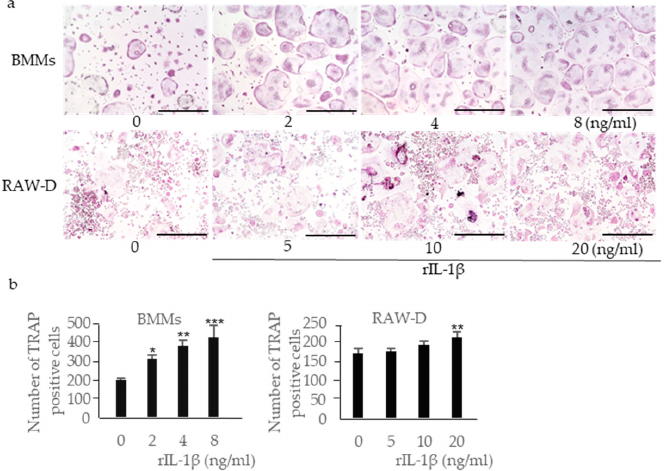
Figure 5. Effects of recombinant (r)IL-1 β on osteoclastogenesis. BMMs were incubated with 30 ng/mL M-CSF and 20 ng/mL RANKL for 48 h. Then, the cells were incubated for 24 h with the same concentration of M-CSF, RANKL, and rIL-1 β . RAW-D cells were incubated with 20 ng/mL RANKL for 48 h. Then, the cells were incubated for 48 h with the same concentration of RANKL and rIL-1 β . These cells were subjected to TRAP staining ( a ), and TRAP-positive cells with more than three nuclei were counted ( b ). Scale bar = 500 μ m. The differences between the groups were analyzed by one-way ANOVA followed by a Tukey test for multiple comparisons. * p < 0.05 ** p < 0.01 *** p < 0.001 compared with controls containing no rIL-1 β . BMM, bone marrow macrophage; M-CSF, macrophage colony-stimulating factor; TRAP, tartrate-resistant acid phosphatase.